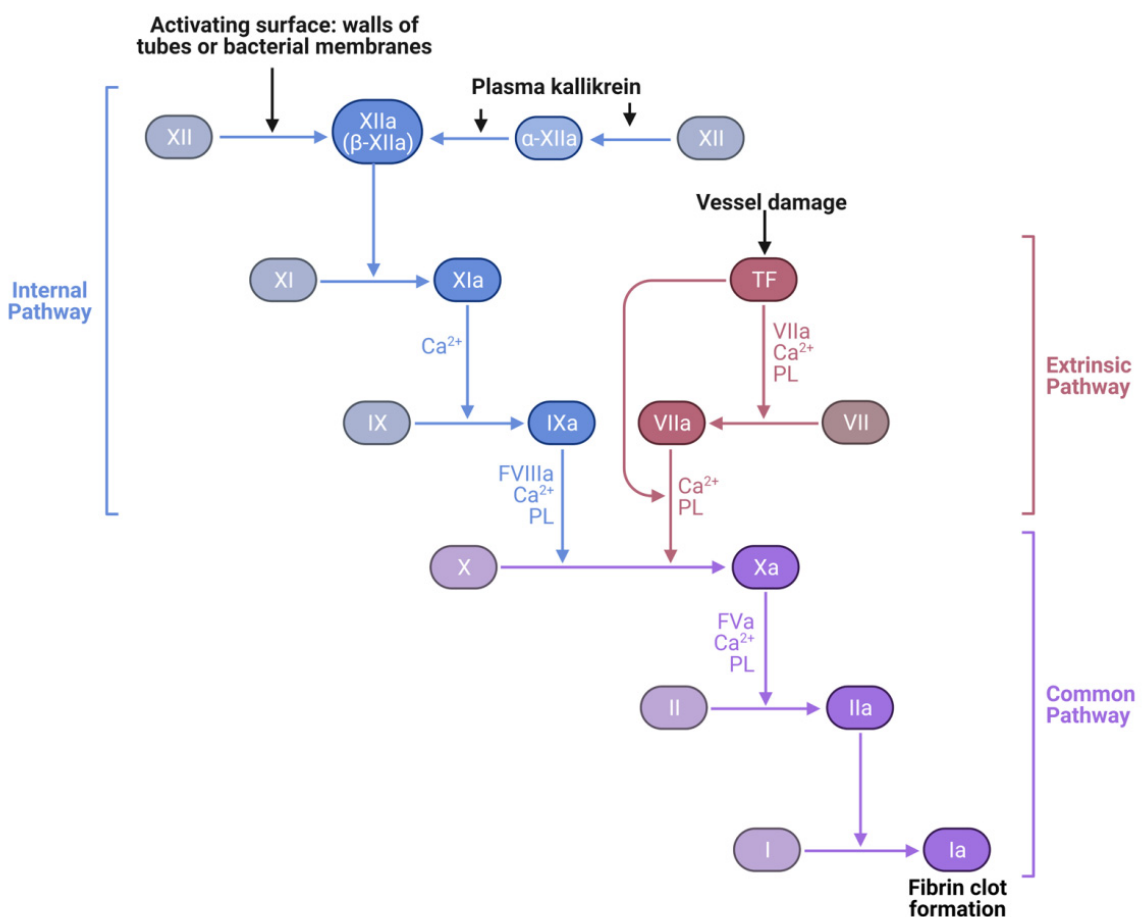
Figure 1. Reactions of the plasma blood coagulation system. Roman numerals—coagulation factors; TF—tissue factor; PL—phospholipids; Ca 2+ —calcium ions. The reactions of converting coagulation factors into active forms are shown by horizontal arrows; vertical arrows indicate which reaction is catalyzed by each factor. Adapted from “Coagulation Cascade” by BioRender.com (2021). Retrieved from https://app.biorender.com/biorender-templates.